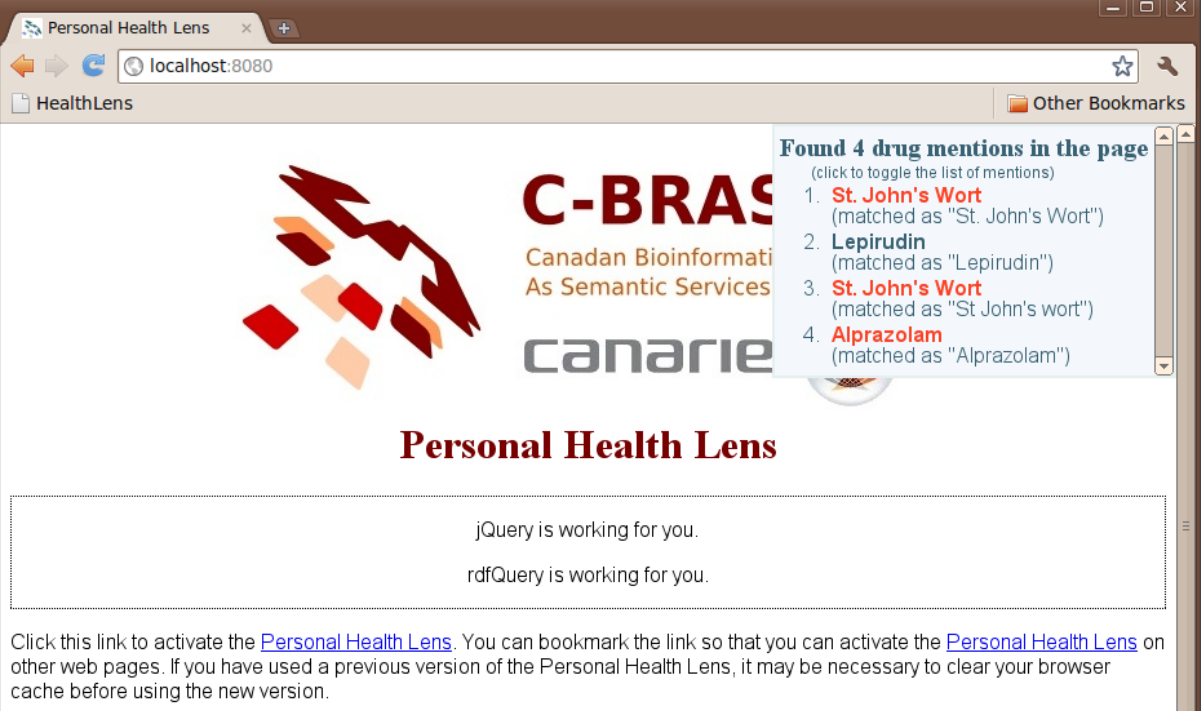
Figure 2. The test page for the Health Lens system, after being scanned with the bookmarklet. St. John’s Wort is annotated with a warning due to a conflict with Alprazolam, a prescribed drug in the sample personal health profile. The test page provides a mechanism to verify that all components of the system are working correctly, independently of the varying structure and content of real